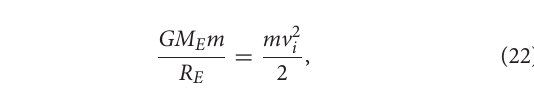
r i , and (C) r f > r i =